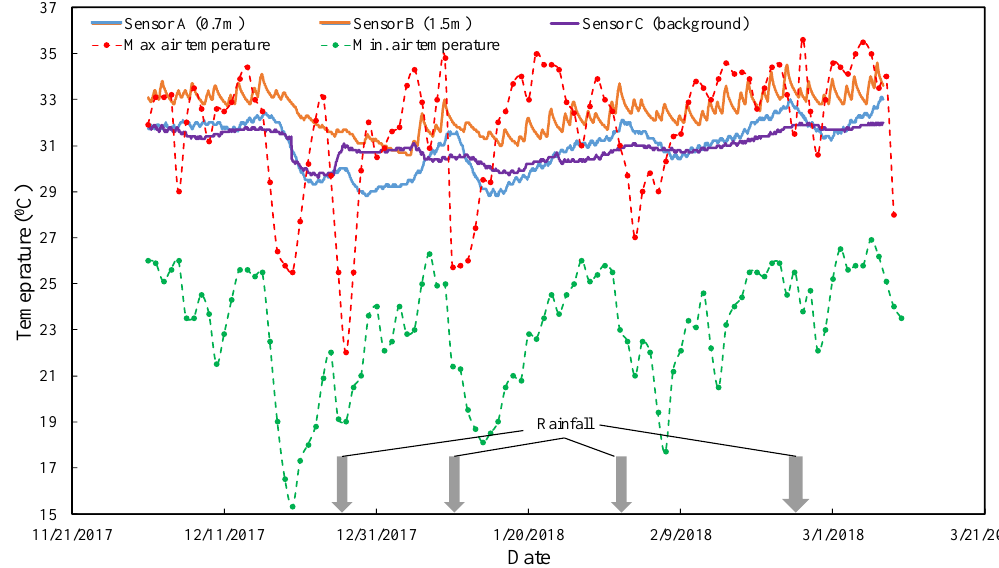
Figure 17. Ground temperatures and maximum–minimum daily air temperatures.